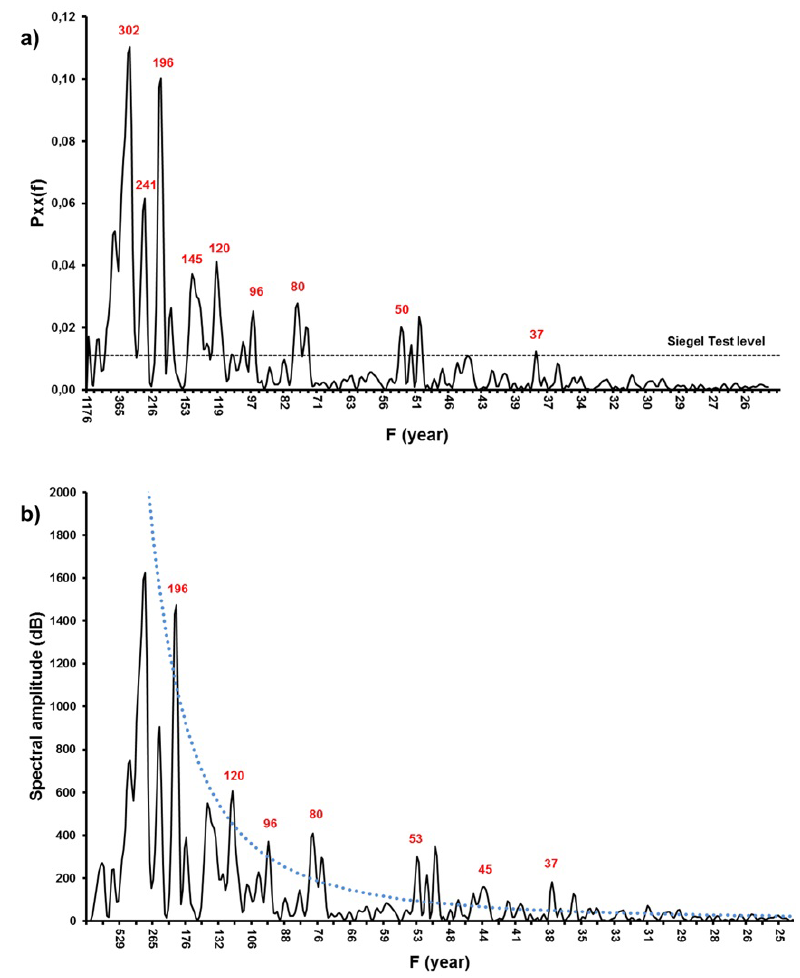
Figure 6. (a) Harmonic analysis of the composite palaeoflood record of the Hasli–Aare Delta plain. Dotted line represents critical level for the Siegel test and significant frequencies are shown in years. (b) Red-noise spectra of the composite palaeoflood record. Dotted line shows false-alarm level. Significant frequencies are shown in